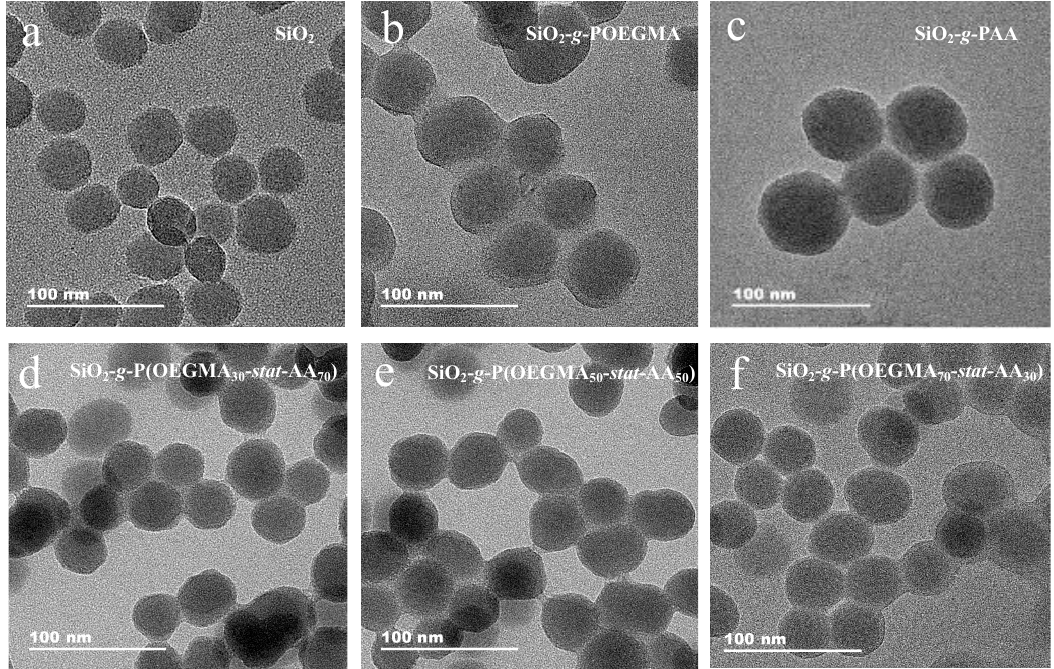
Figure 1. TEM images of bare SiO 2 ( a ), SiO 2 - g -POEGMA ( b ), SiO 2 - g -PAA ( c ), SiO 2 - g -P(OEGMA 30 - stat -AA 70 ) ( d ), SiO 2 - g -P(OEGMA 50 - stat -AA 50 ) ( e ), and SiO 2 - g -P(OEGMA 70 - stat -AA 30 ) ( f ).